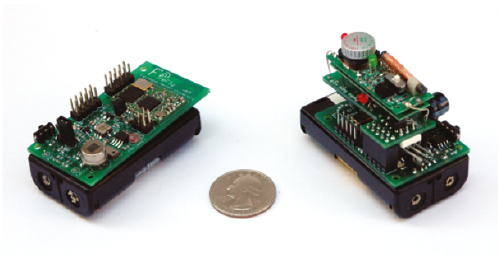
Figure 19: FireFly node with sensors on the left; on the right FireFly node with add-on radio receiver.